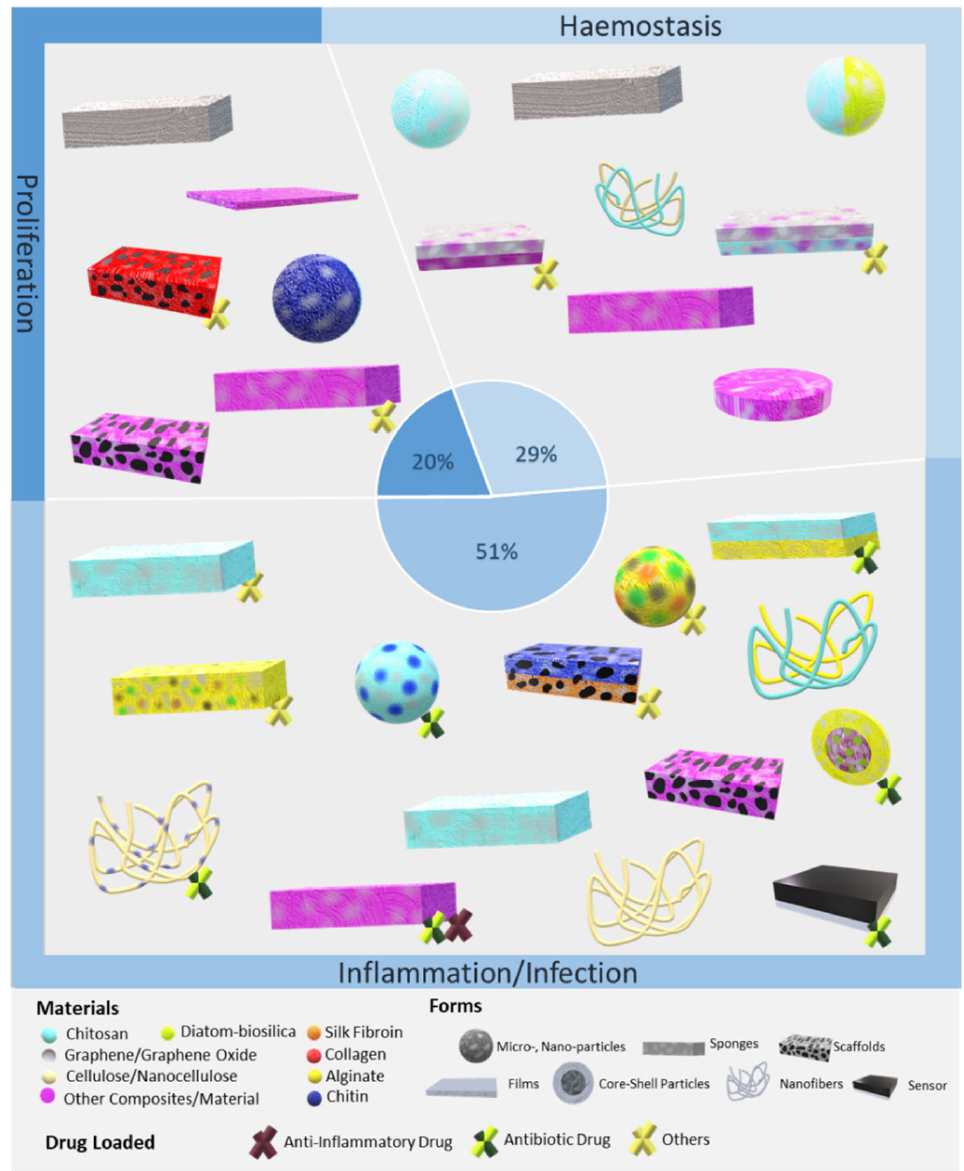
Figure 4. Bioaerogel formats with or without bioactive compounds that showed beneficial effects in the different phases of wound healing. Pie graph (center) denotes the percentage of articles on aerogels sorted by wound stage treatment. The same article database as in Figure 1 was used.